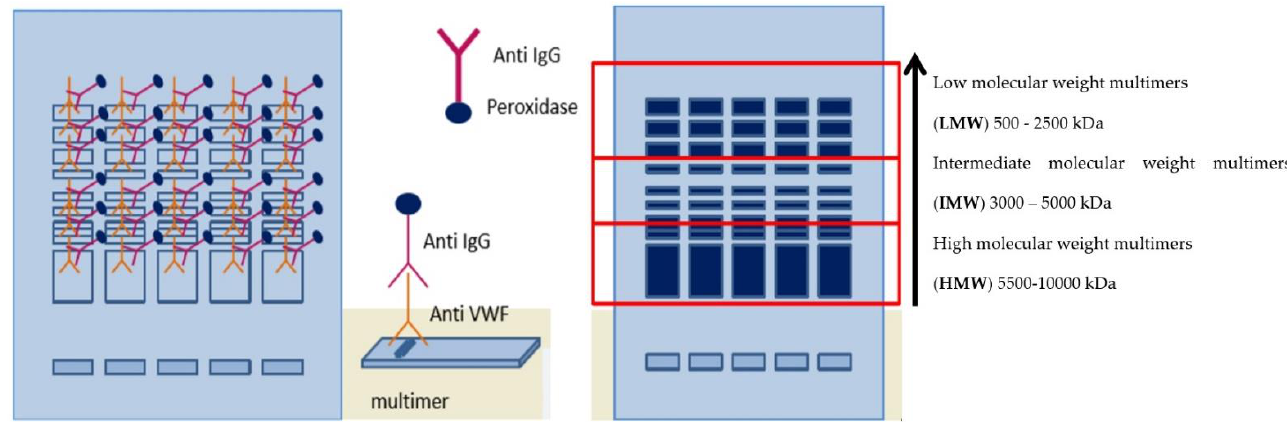
Figure 2. Principle of the determination and visualization of VWF multimers via the semi-automatic method of Hydrasys 2 scanning. Incubation of the first immunofixation of VWF multimers in a gel with a polyclonal anti-VWF-IgG antibody, and incubation of the second immunofixation with peroxidase-conjugated anti-IgG antibody. The gel was subsequently incubated in peroxidase and chromogen substrate (TTF1/TTF2), then dried and prepared for interpretation (own data).